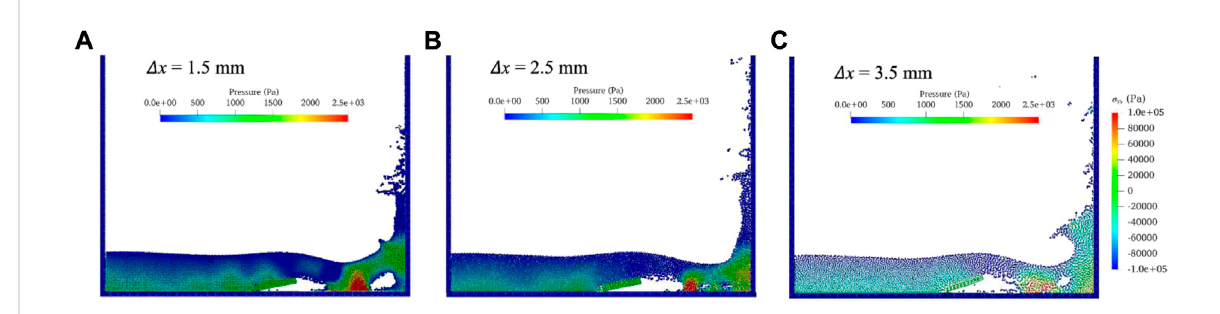
FIGURE A1 Contours of water pressure, surface pro fi le and σ yy of elastoplastic baf fl e of (A) Δ x = 1.5 mm, (B) Δ x = 2.5 mm, (C) Δ x = 3.5 mm.